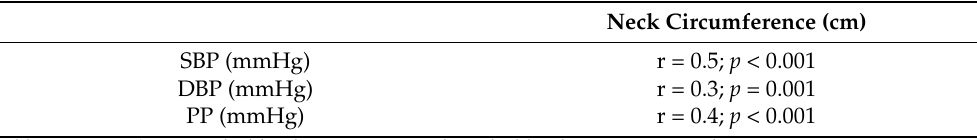
Table 2. Pearson correlations between the neck circumference and blood pressure.